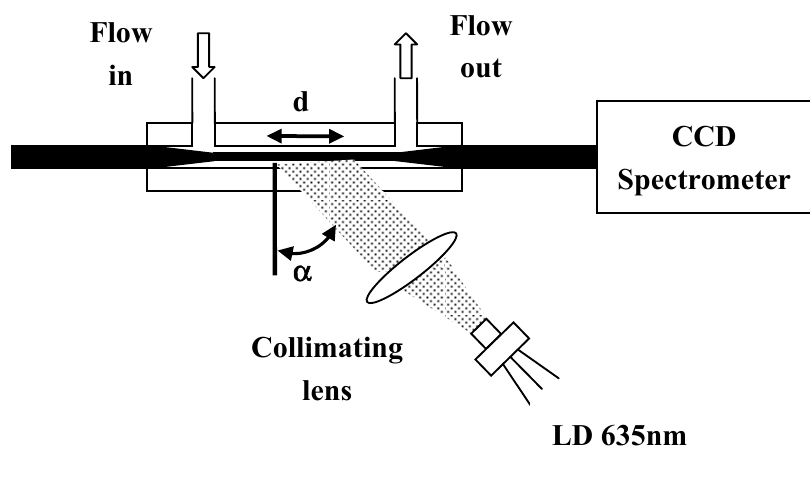
Figure 9. Measurements setup for fluorescence measurements.